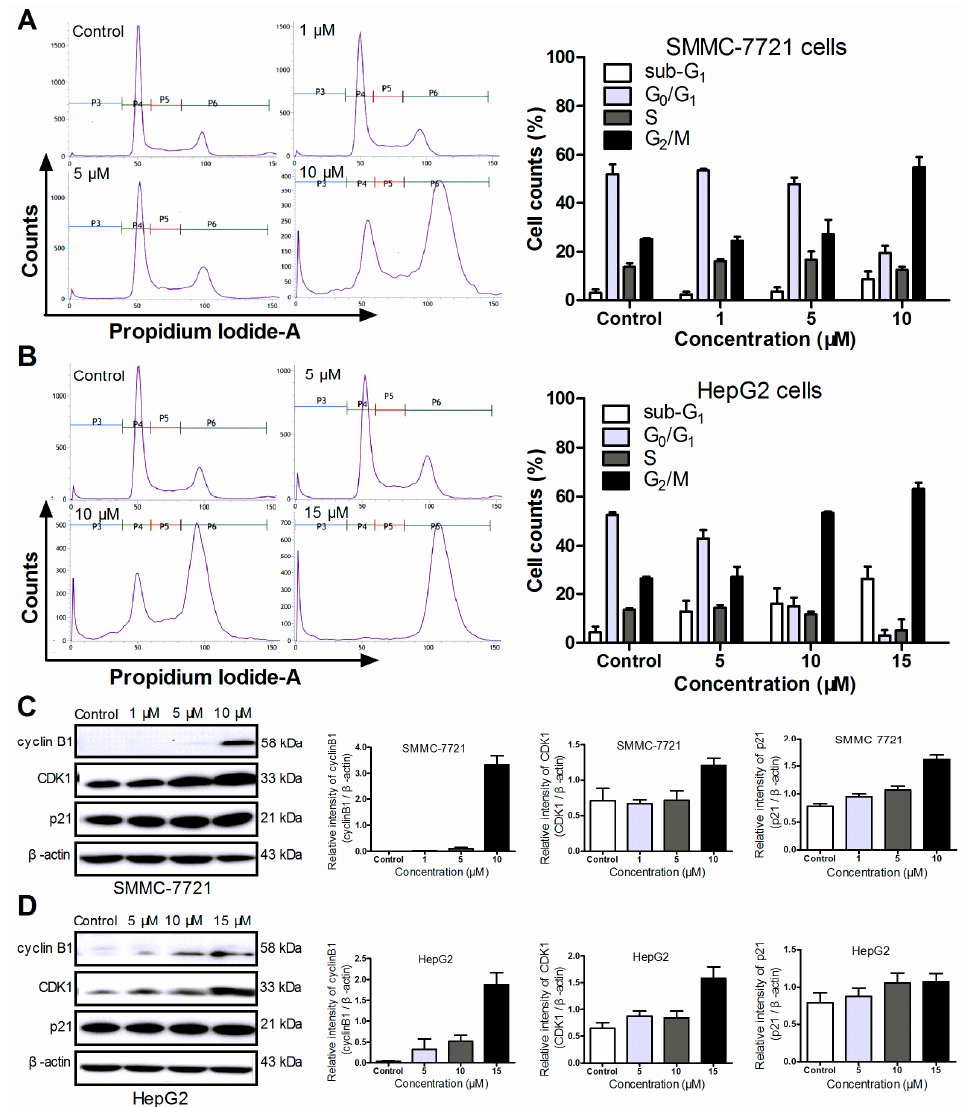
Figure 4. Cell cycle distribution was analyzed after compound 3a treatment for 48 h. ( A ) The effect of compound 3a on cell cycle was detected in SMMC-7721 cells. Cell cycle was significantly arrested in G2/M phase in a dose-dependent manner P3: sub-G1, P4: G 0 /G 1 , P5: S, P6: G 2 /M; ( B ) The effect of compound 3a on cell cycle was detected in HepG2 cells. Cell cycle was significantly arrested in G2/M phase in a dose-dependent manner; ( C ) The expression levels of cell cycle-related proteins, including cyclin B1, CDK1 and p21, were analyzed by western blotting in SMMC-7721 cells; ( D ) The expression levels of cell cycle-related proteins, including cyclin B1, CDK1 and p21, were analyzed by western blotting in HepG2 cells. All of the experiments were repeated three times for each group and the other results were consistent.